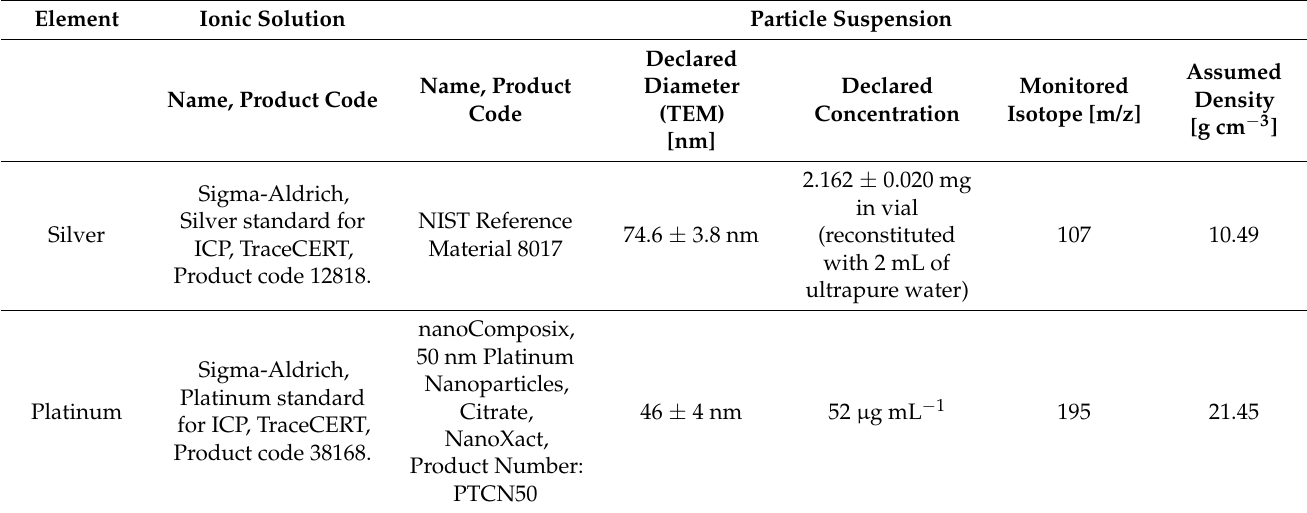
Table 4. Specification of ionic/particle